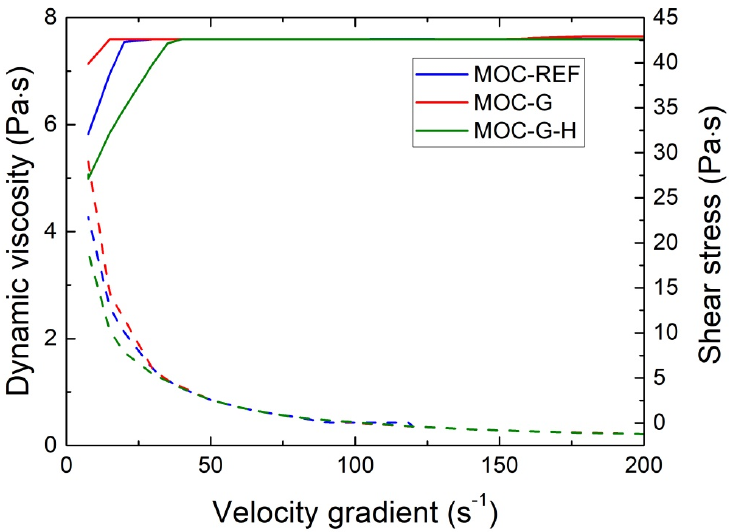
Figure 4. Shear stress and dynamic viscosity of the fresh composite mixtures.